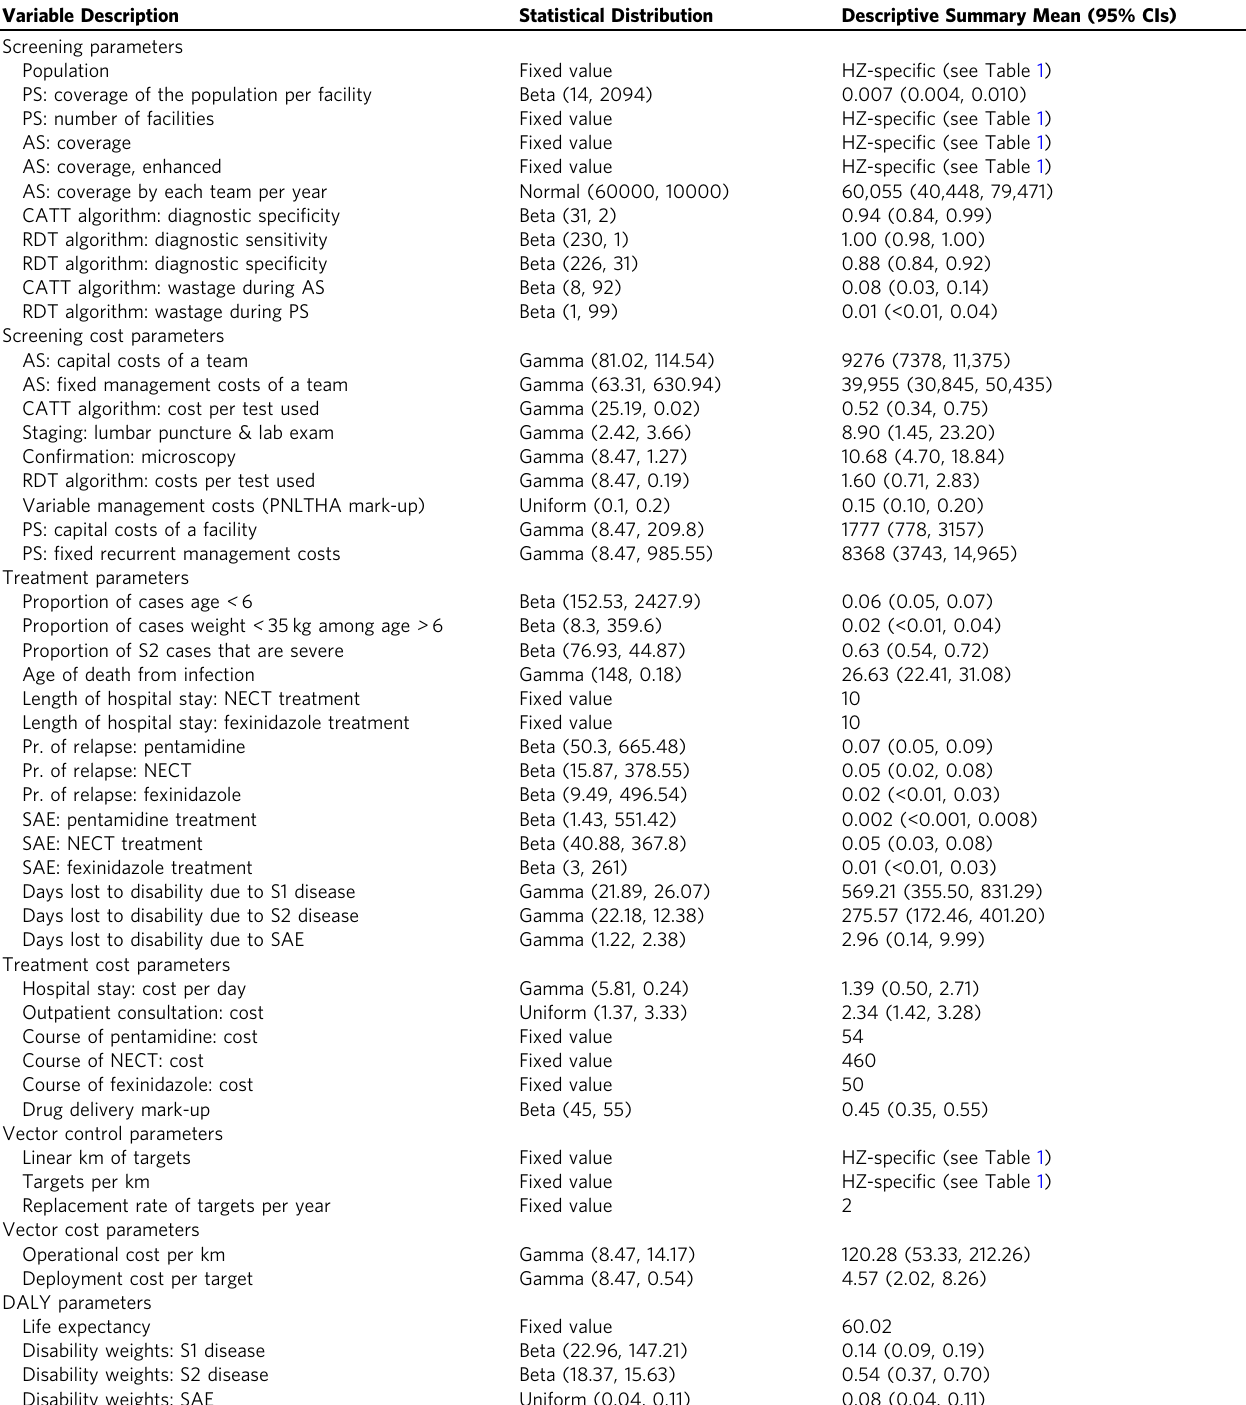
Table 5 Model Parameters. For further details and sources, see Section